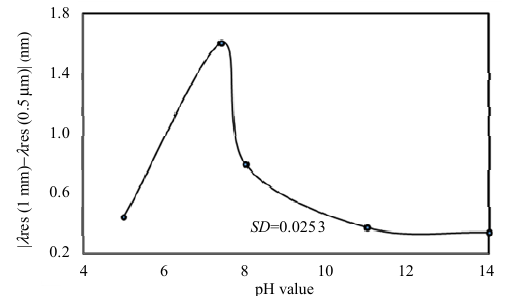
Fig. 14 pH test to determine the solubility of AA molecules.